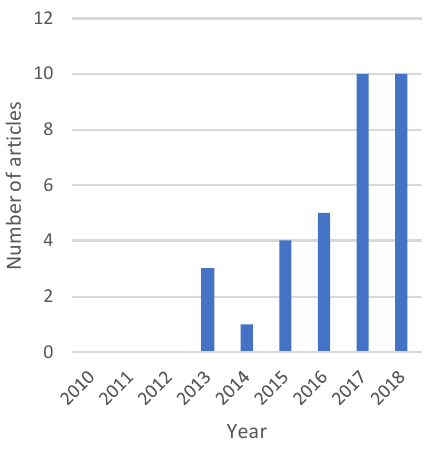
Figure 1. Histogram of located research papers according to year of